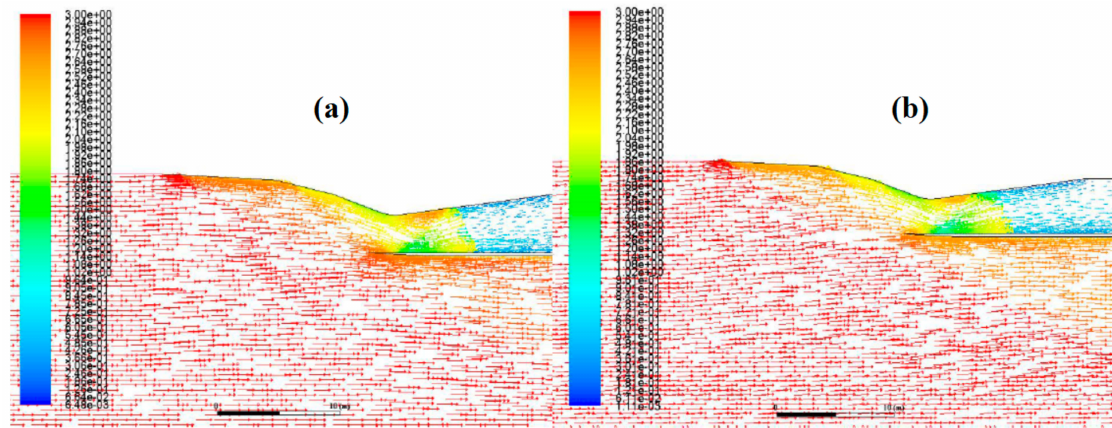
Figure 10. ( a ) Mach 3, angle of attack (AoA) of 0 ◦ and ( b ) Mach 3, AoA of 3 ◦